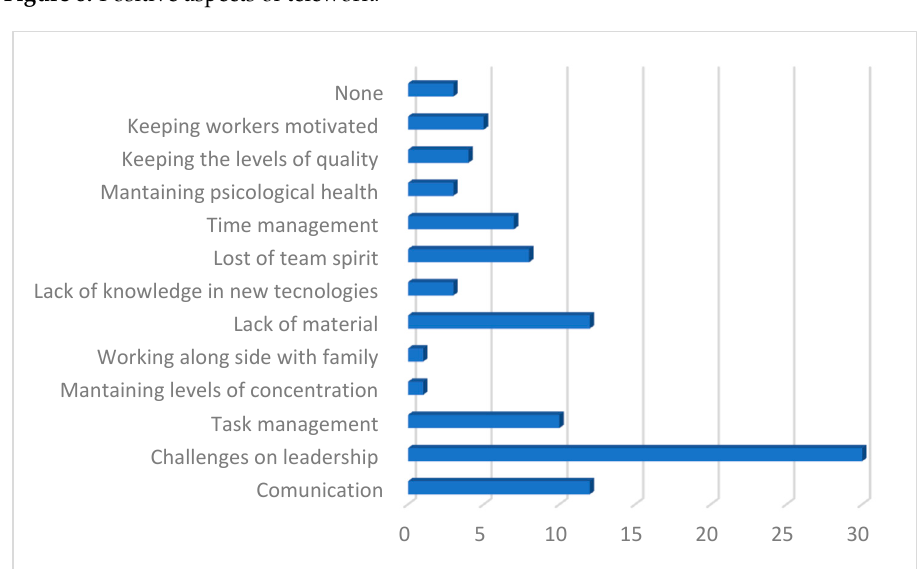
Figure 9. Negative aspects of telework.